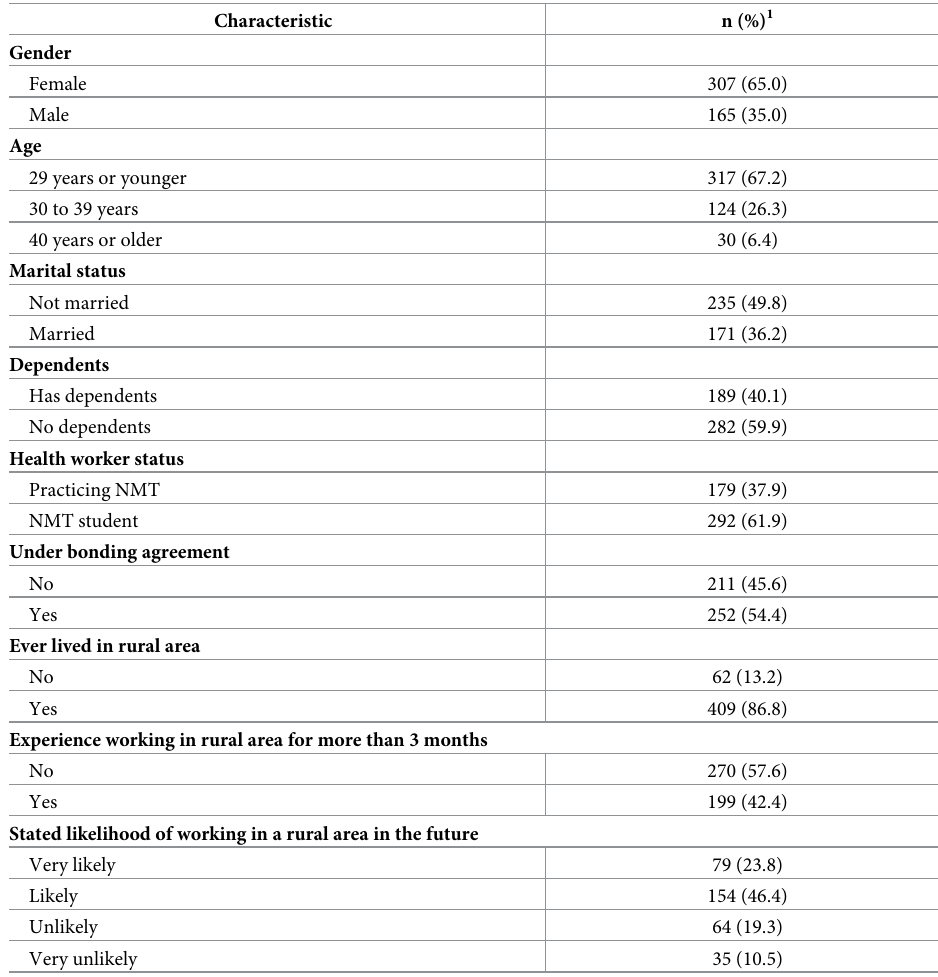
Table 2. Participant demographic characteristics.